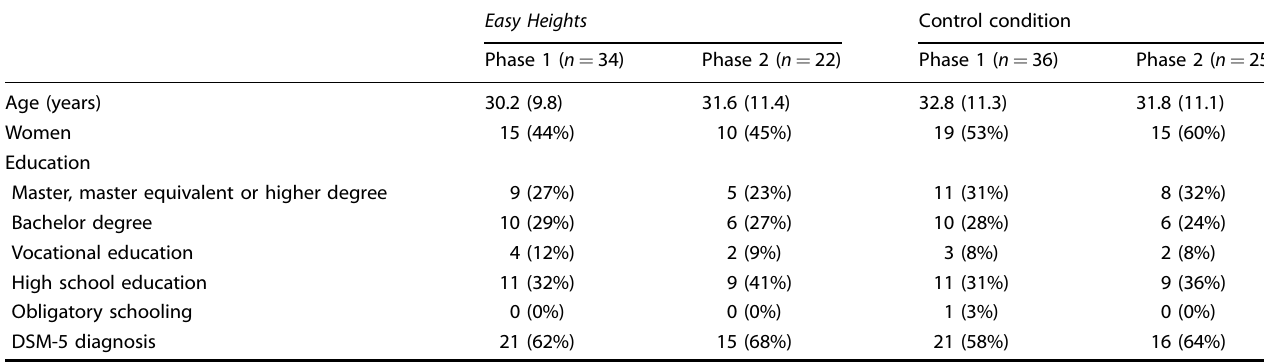
Data are numbers of participants or mean Table 2 summarizes the mean scores of the primary and (acute use) with respective baseline calculated with values of all